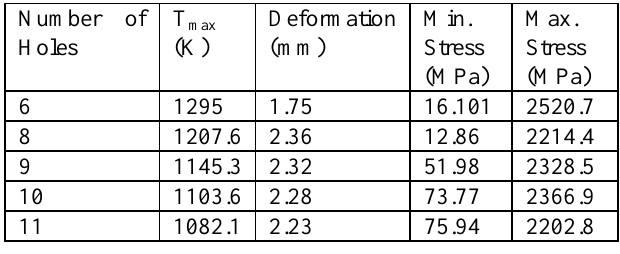
Table2: Inconel Material simulation results Number of Holes